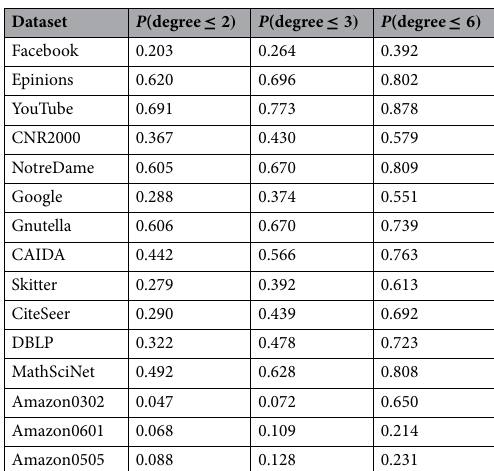
error bar indicates the standard deviation across 100 independent sets of randomly missing nodes.